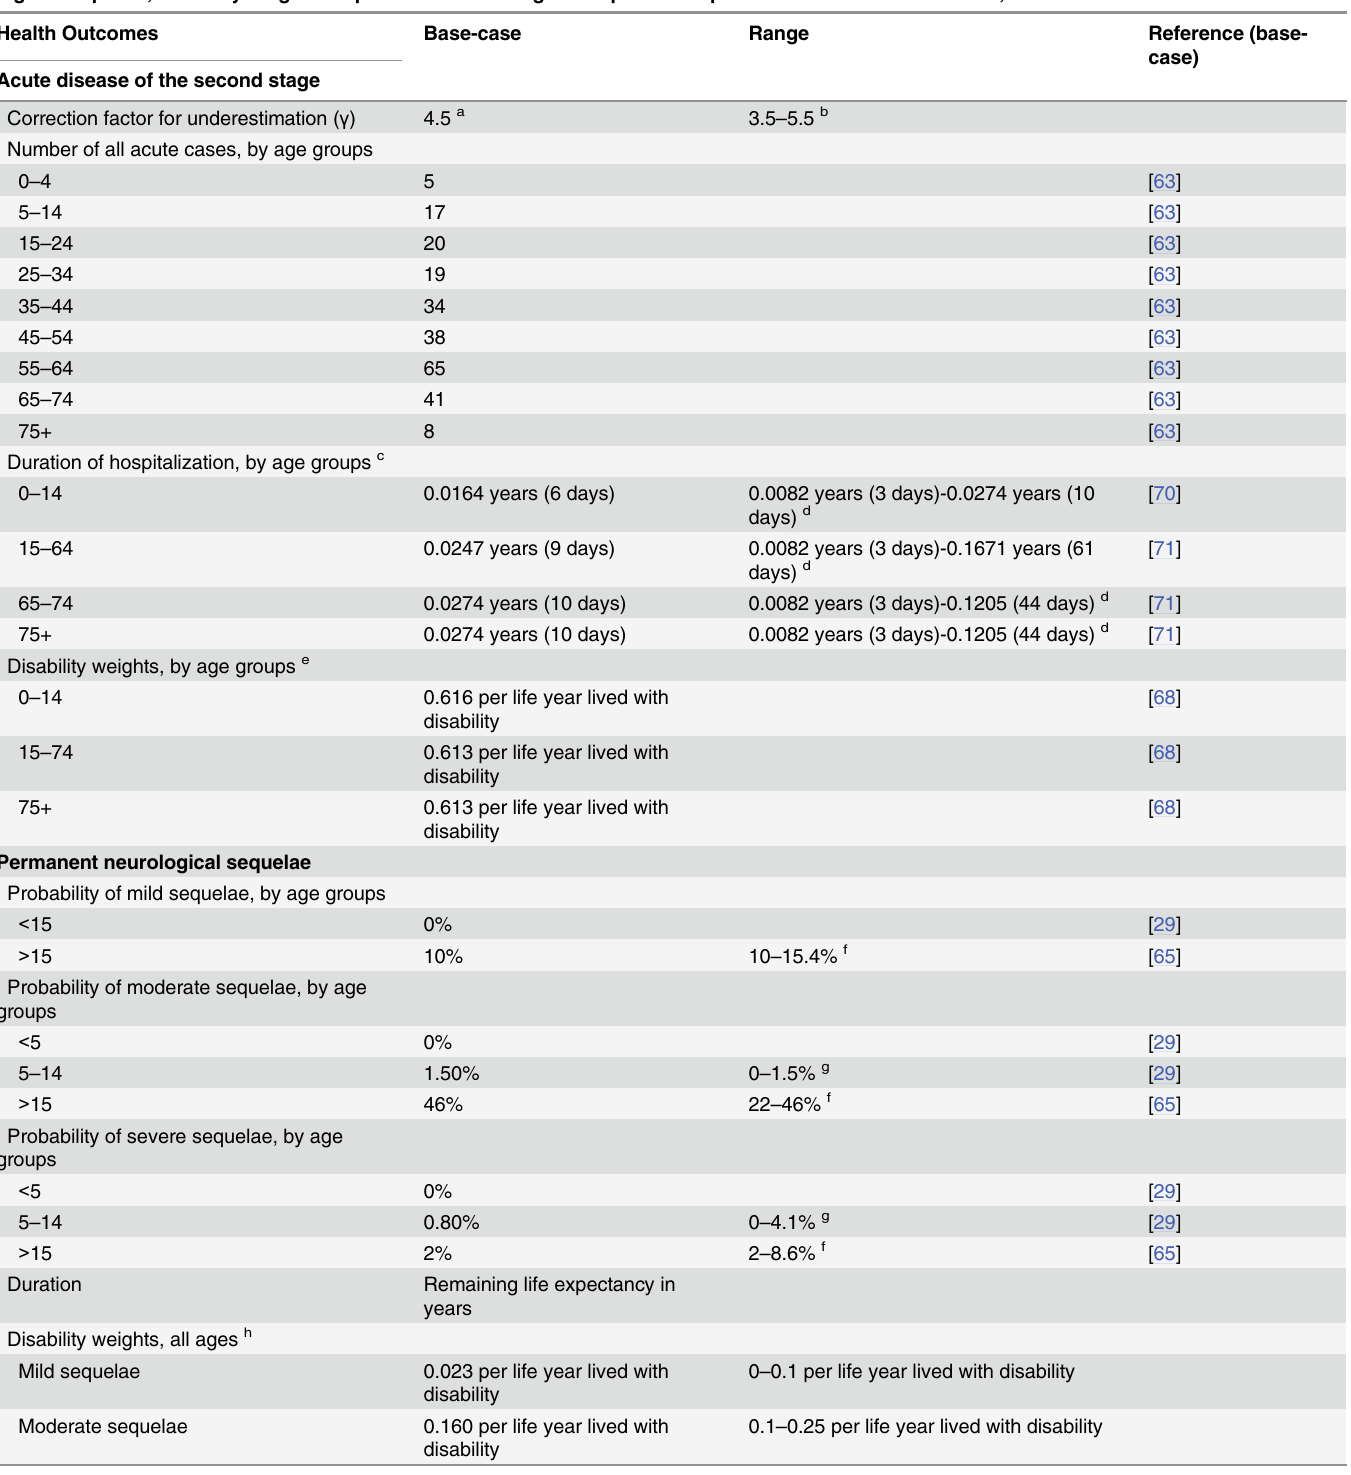
Table 1. Model input parameters for calculating DALYs of TBE: the number of reported cases with acute disease of the second stage for 2011, duration of the acute disease of the second stage, disability weights for the acute disease of the second stage, probabilities of permanent